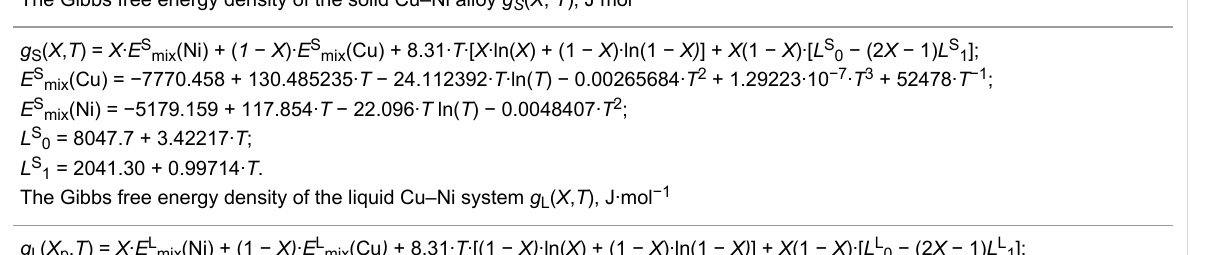
Table 2: Thermodynamic data and the Gibbs free energy densities of the liquid and solid Cu–Ni